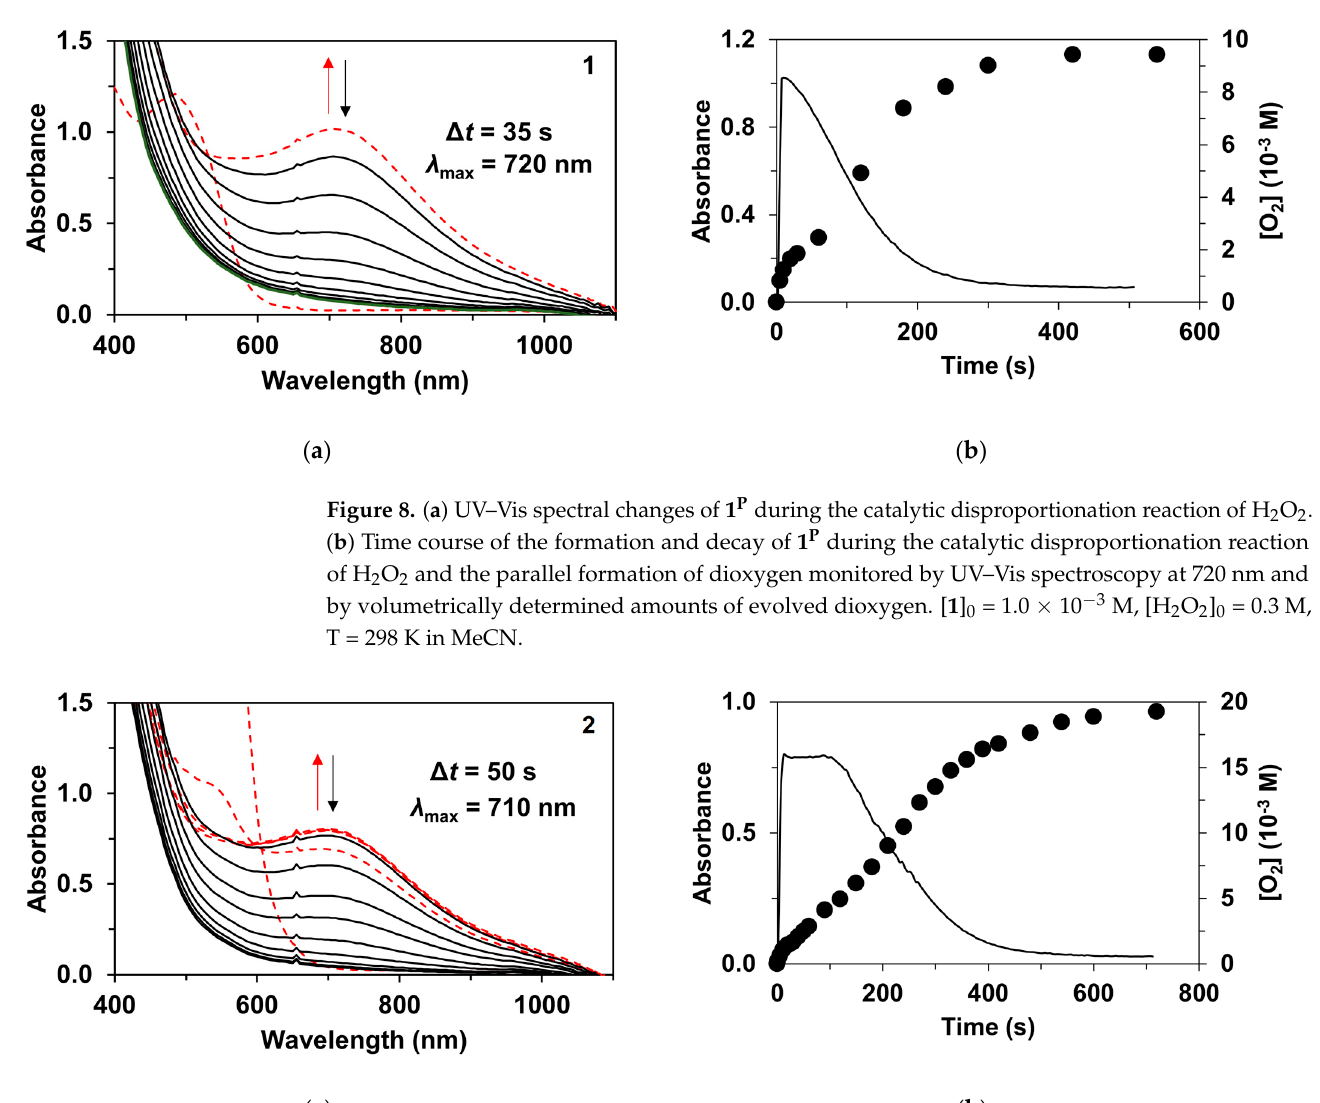
V i = 5.65 × 10 − 5 M s − 1 and V i = 59.2 × 10 − 5 M s − 1 , respectively to compounds 4 , 1 , 2 , 3 and 5 , respectively, at 298 K. Based on the observed initial rates, compound 5 has significantly higher reactivity than 4